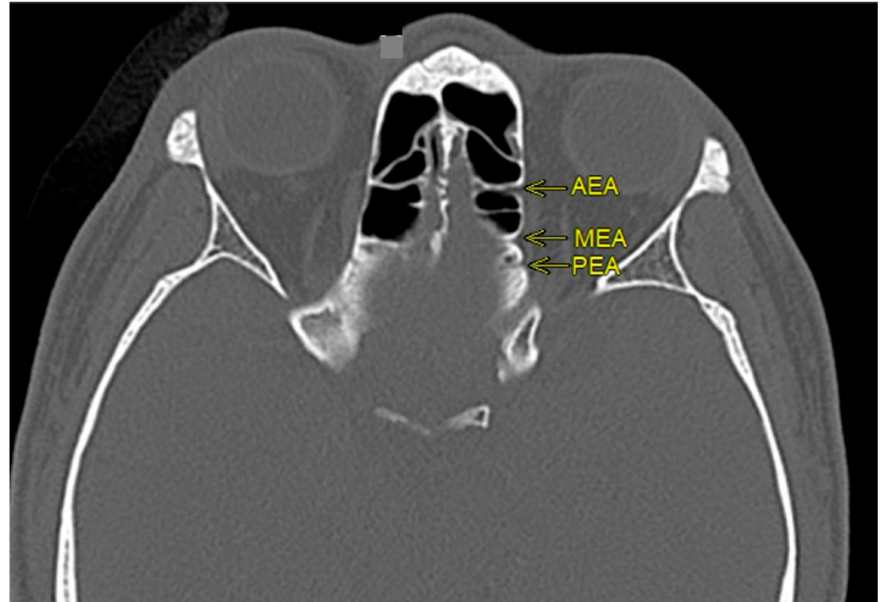
Figure 3. Computed tomography of paranasal sinuses (axial view) of the anterior ethmoidal (AEA), middle ethmoidal (MEA) and posterior ethmoidal arteries (PEA).